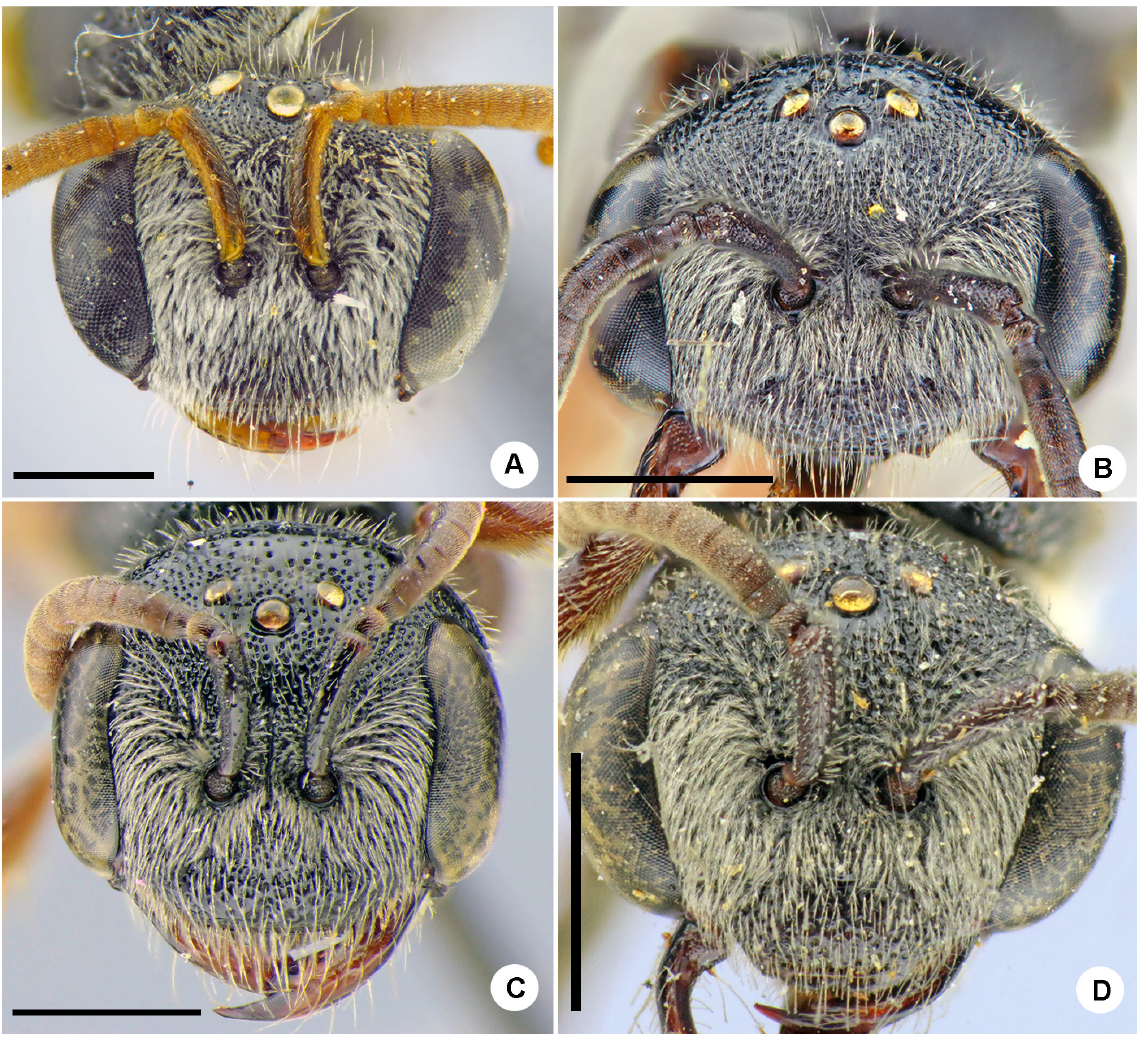
Fig. 5. Head in frontal view, females. A . Sphecodes cameronii (Bingham, 1897). B . S. laticeps